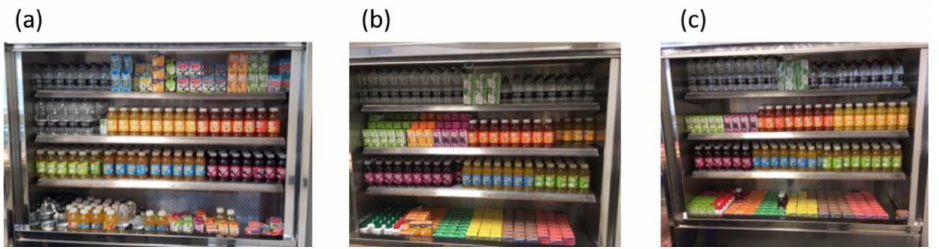
Figure 2. An example of the sugar-sweetened beverage intervention by time period (school B); ( a ) T1 and T2 (control) no intervention had taken place ( b ) T3 (intervention) drinks were re-positioned in order of sugar content; least sugar content at the top (i.e., water & plain milk) to most sugar content at the bottom (i.e., fruit juice from concentrate and flavoured milks ( c ) T4